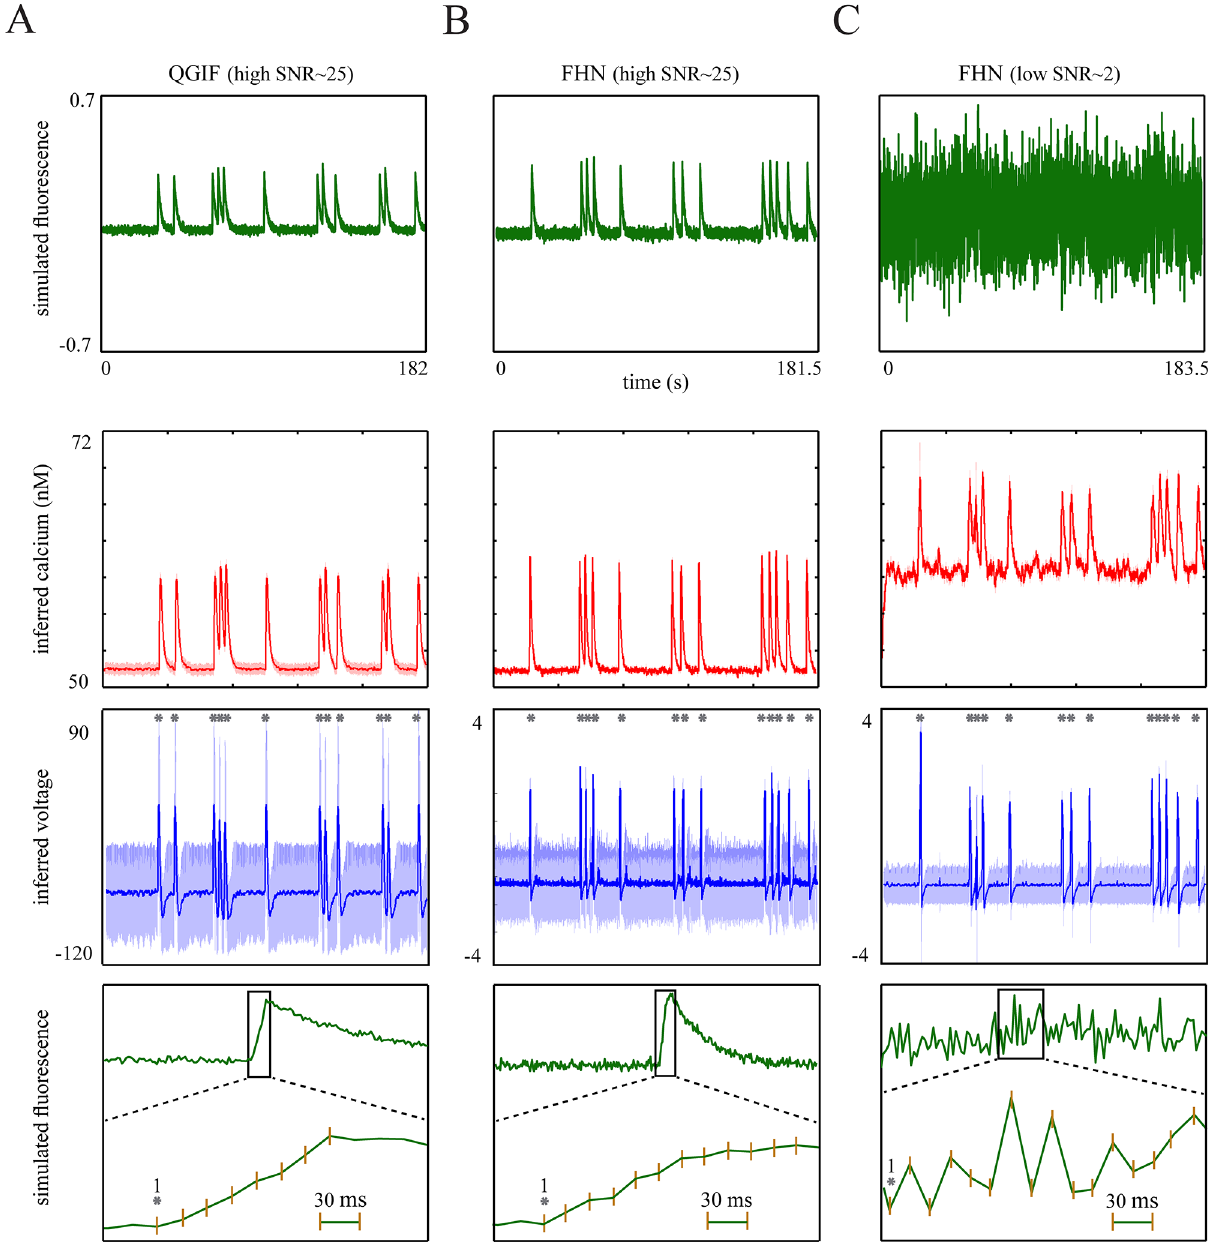
Fig 5. Results of the proposed approach for synthetic single-spike-evoked transients with slow rise times (around 200 – 450 ms). ( A ): QGIF model, ( B ): FHN model with high SNR, ( C): FHN model with low SNR. First row: Fluorescence traces generated by each of the two non-bursting generative models. The rising kinetics of all transients were stretched using interpolation, Second row: Inferred non-saturating [Ca 2+ ] kinetics, Third row: Inferred membrane potentials, where the synthetic spikes as indicated by grey stars are closely matched by the inferred spikes, Fourth row: Zoom into the interpolated, slow rise time of the first fluorescence transient in the traces shown in the first row. The time from the simulated spike (grey star) to the peak was roughly 200 – 450 ms . The decaying time-constant of the transients was about 2 seconds.